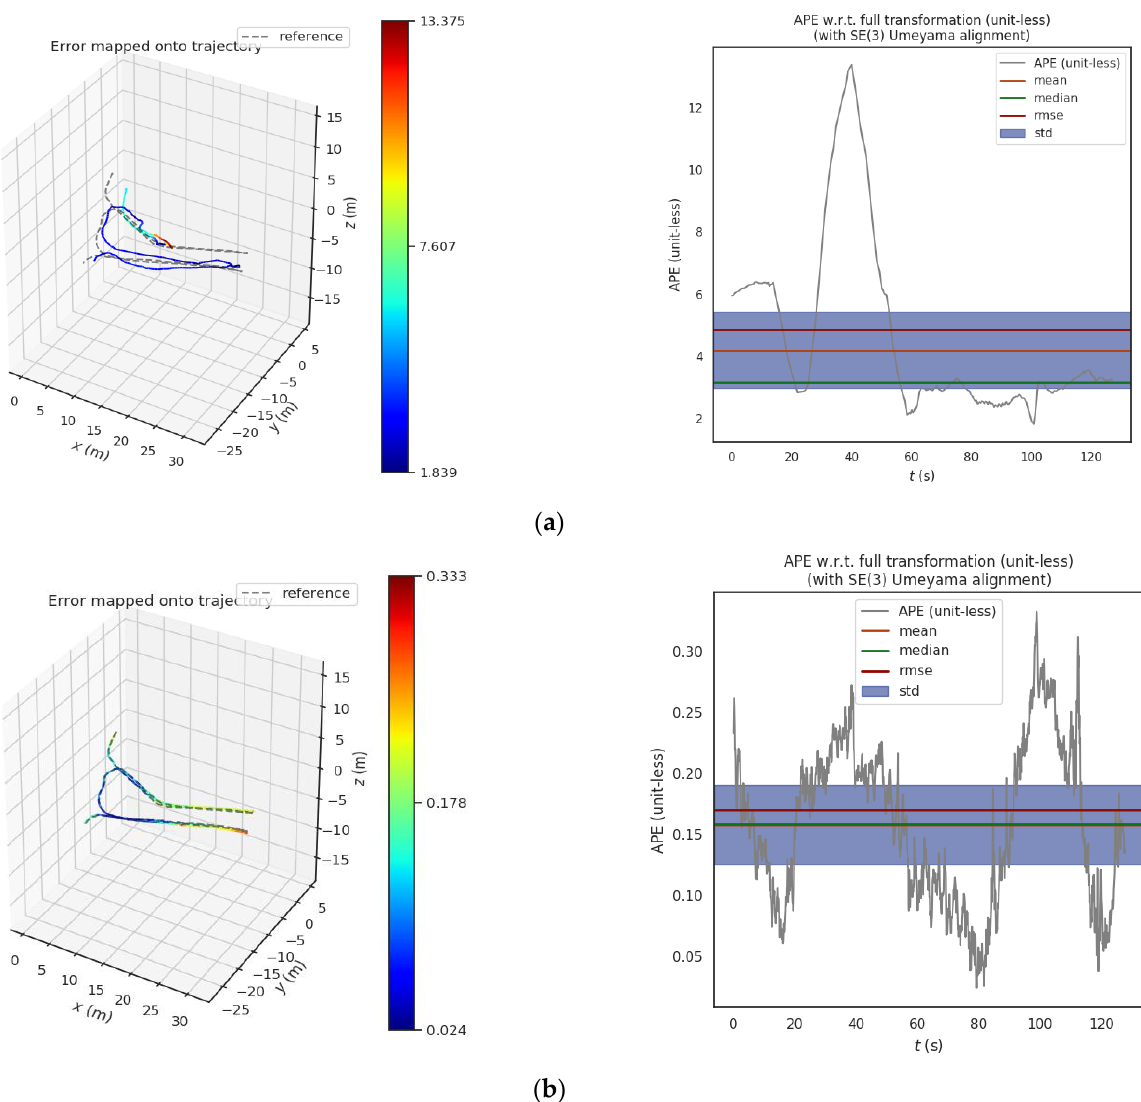
Figure 13. Comparison of absolute position and pose errors of different methods in Experiment 4; ( left ) the comparison between the trajectory and the true value; ( right ) the change of absolute position and pose error with time. ( a ) Comparison between method LiDAR_with_GICP track and true value; ( b ) Comparison between method LiDAR_with_imu track and true value.